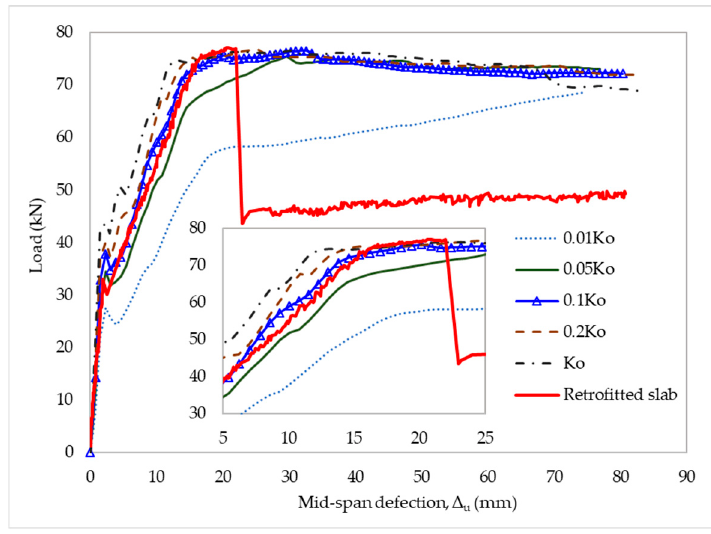
Figure 13. Sensitivity to initial stiffness of interface elements.